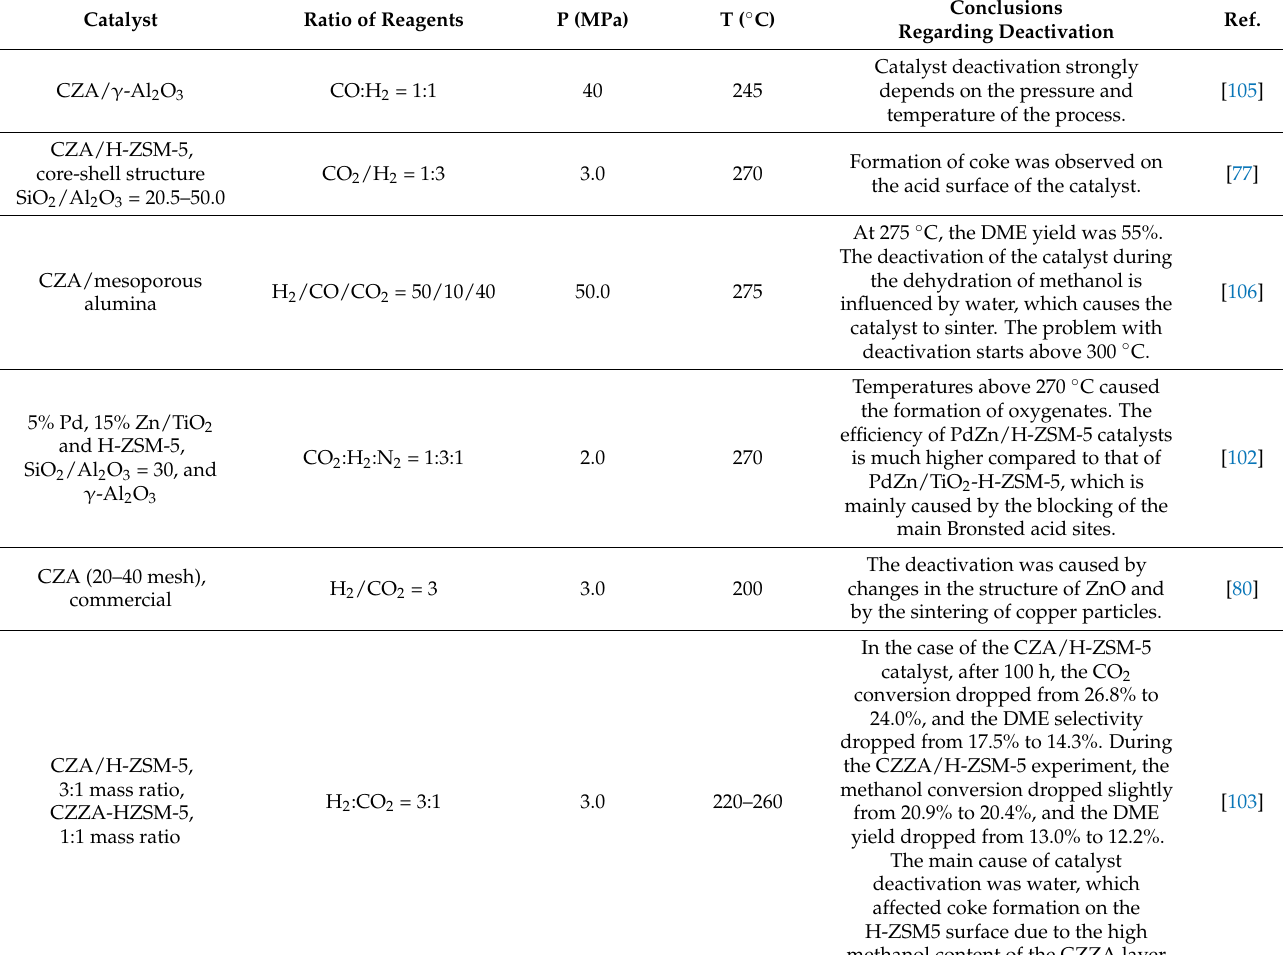
Table 1. Deactivation of the catalyst in a fixed-bed reactor